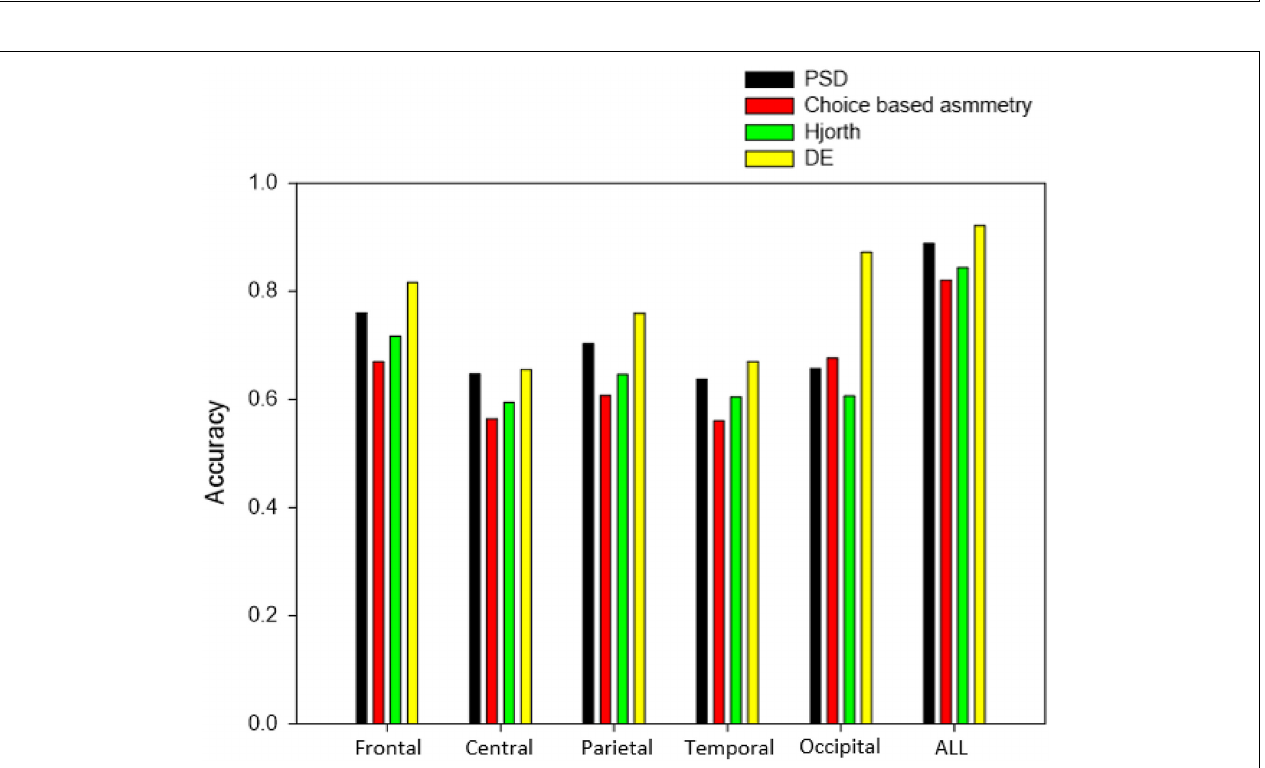
FIGURE 8 | Classification accuracy of different brain lobes based on different feature